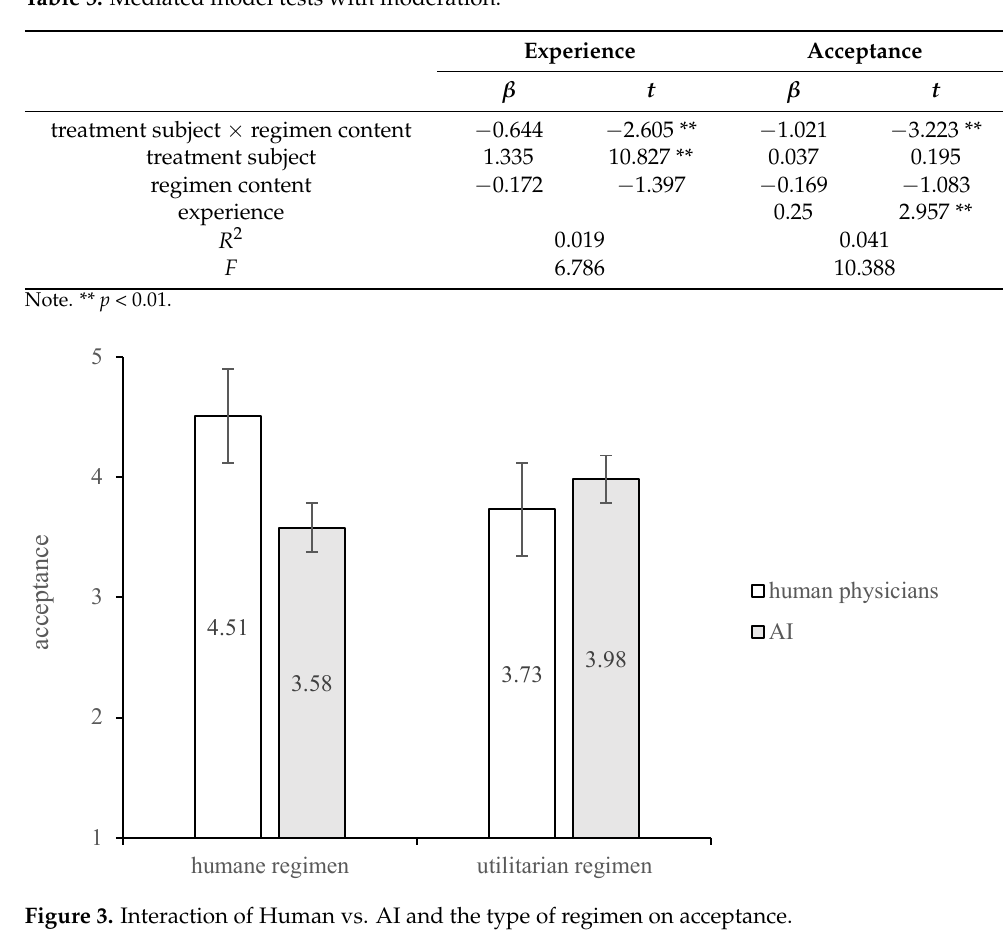
Table 5. Mediated model tests with moderation.